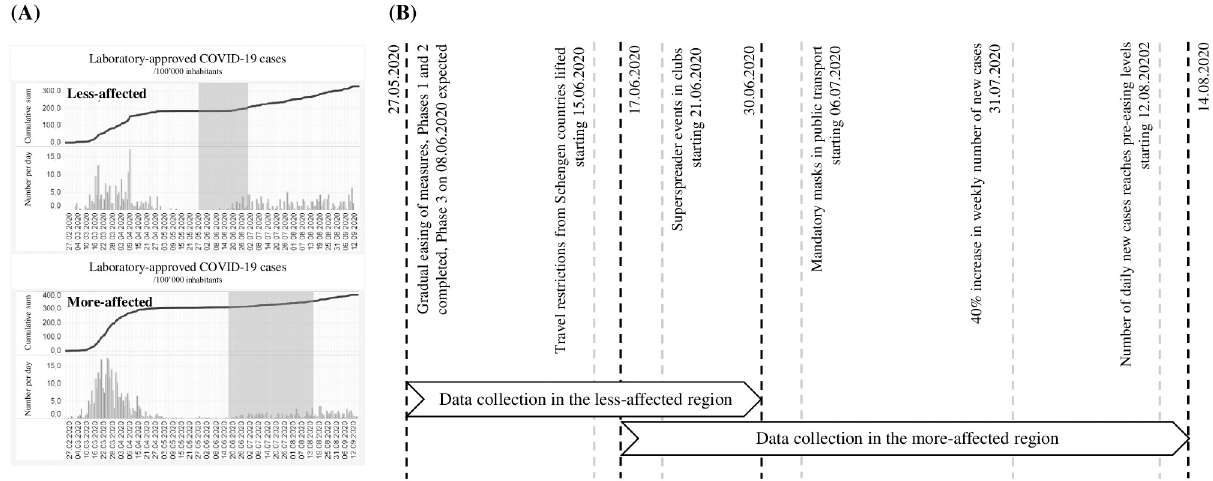
Fig 1. Timeline. (A) Development of COVID-19 in the less-affected and more-affected region relative to data collection periods, according to FOPH (B) Timeline of the study and COVID-19 policy milestones and debates in